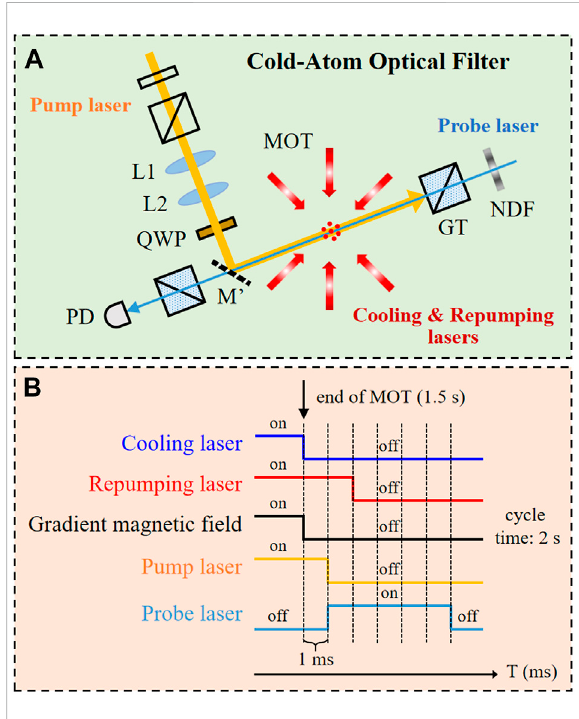
FIGURE 3 (A) Schematicoftheexperimentalsetup.NDF:neutraldensity fi lter; GT: Glan-Taylor prism; PD: photo-electric detector; L1 and L2: plane-convex lenses; QWP: quarter-wave plate; M ’ : mirror with re fl ectivity of 10% and transmission of 90%; MOT: magneto-optical trap. The gradient magnetic fi eld coils and geomagnetic fi eld compensation coils of MOT are not shown in fi gure. (B) Relevant time sequence diagram of the